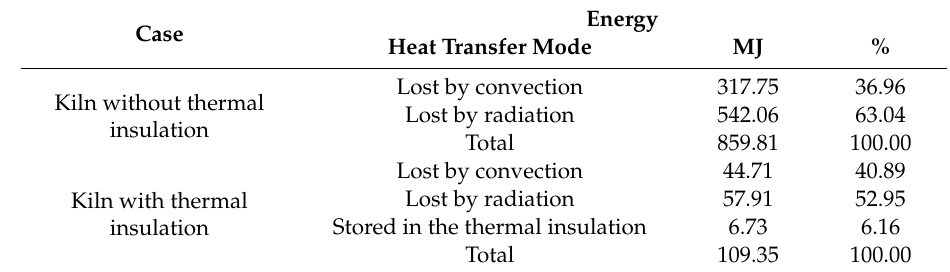
Table 7. Comparison between the energies lost by the sidewalls for the kiln with and without thermal insulation during the heating step.